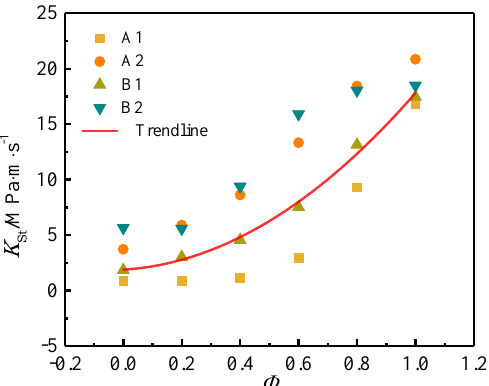
Figure 7. The explosion index K St of coal dust and gas mixtures changing with the gas equivalent ratio.